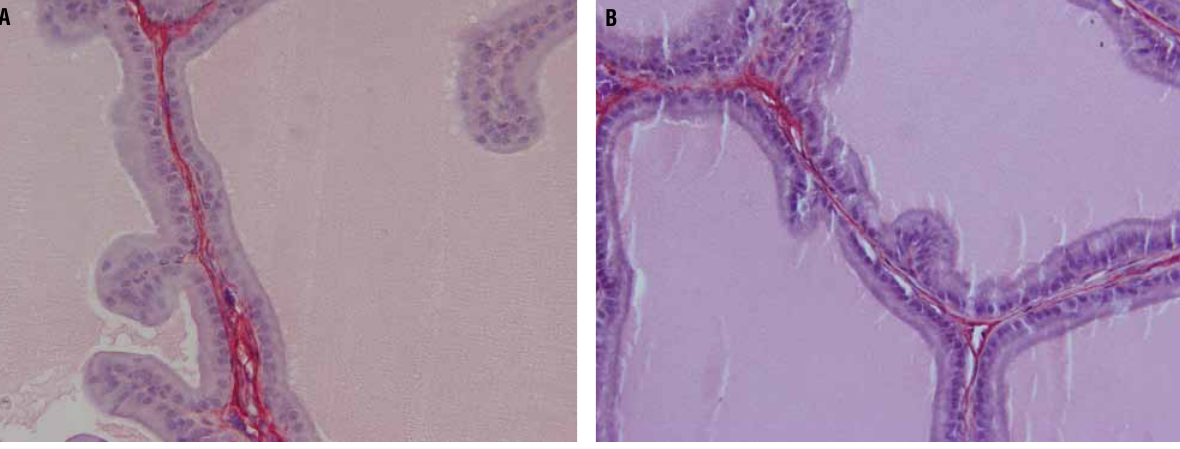
Figure 5 - Photomicrographs showing prostate collagen of rat groups. A) ventral prostate lobe of group T65. The photomicro- graph shows predominance of collagen (red). Picrosirius Red 400x. B) ventral lobe of group C65. Decreased presence can be observed of collagen (red). Picrosirius Red